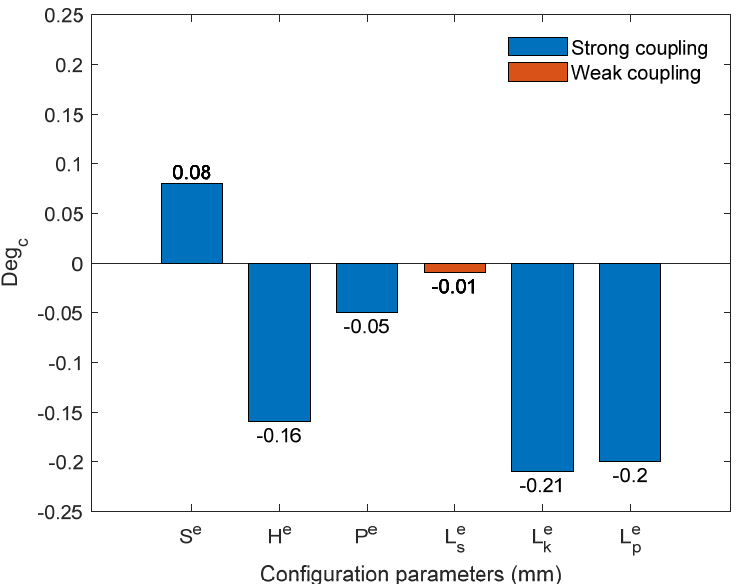
Figure 11. Comparison of electromechanical coupling characteristics of flexible interconnection.